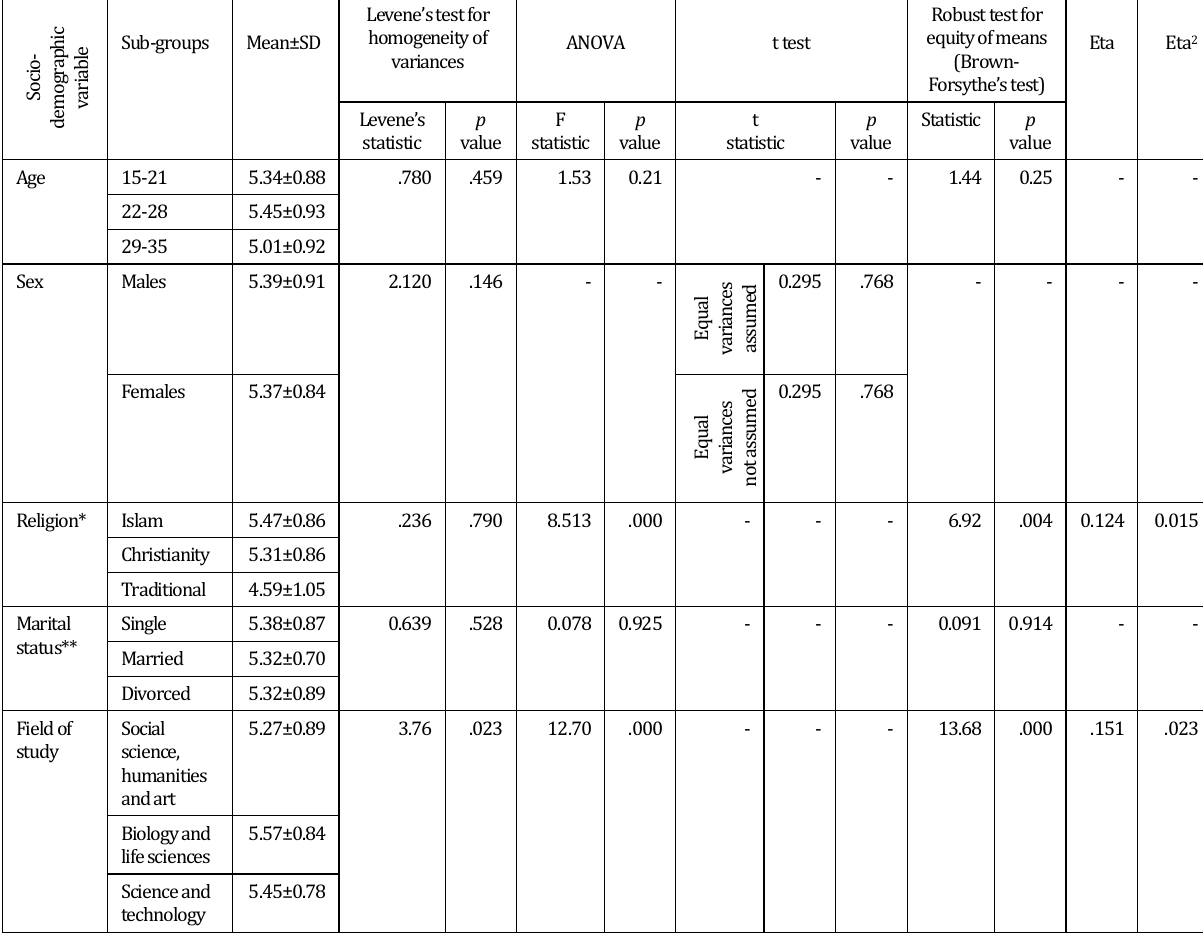
Table 3. Effect of age, sex, religion, marital status and field of study on attitude towards environmental abuse among respondents